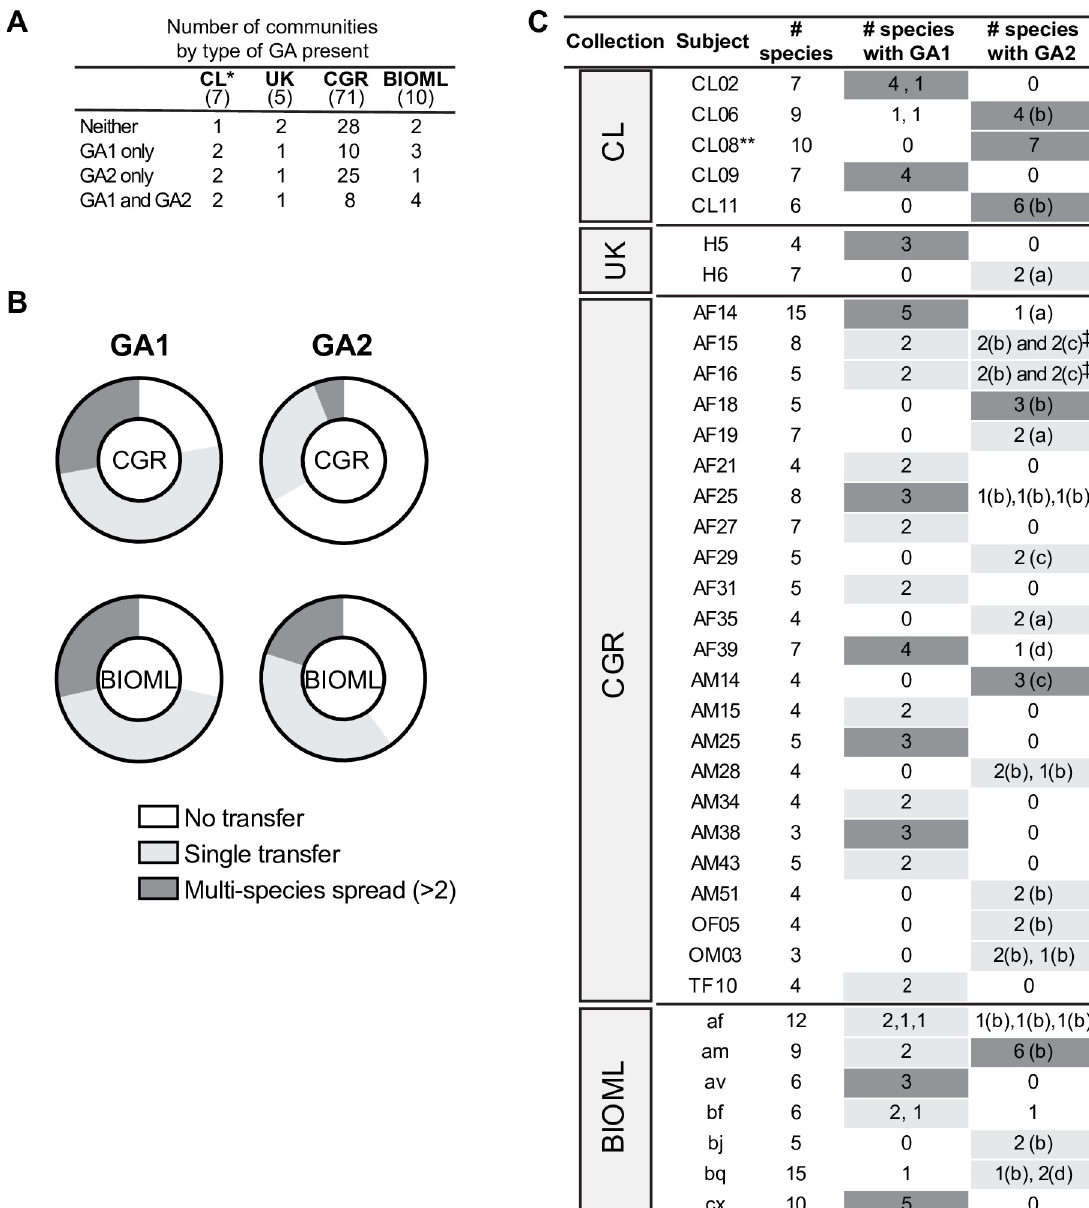
Fig 4. Intra-community spread is common for GA1 and GA2 loci. A. Number of communities per dataset, classified by GA1 and GA2 loci presence/absence. Numbers in parentheses under each dataset name indicate total number of volunteers analyzed in that collection. � Includes CL08 and CL14 which were screened by PCR as described in the text. B. Percentage of communities in the CGR and BIOML collections that show the indicated event, out of the total communities in that dataset that have at least one strain with the indicated GA type: no transfer, single-species spread (present in two species), multi-species spread (present in three species or more) . C. Communities with a single-species intra-community transfer (highlighted in light grey) or multi-species spread (highlighted in dark grey). Letters in parentheses indicate type of GA2. Numbers listed separately in an individual box indicate the T6SS regions are different ( < 99.99% DNA sequence identity and/or divergent variable regions). �� Screened by PCR and sequencing of variable region, as described in the text. Species determined by 16S rRNA gene sequence. ‡The two relevant strains from donor AF15 and AF16 are nearly clonal and appear to have both a GA2b and GA2c (see details in text).